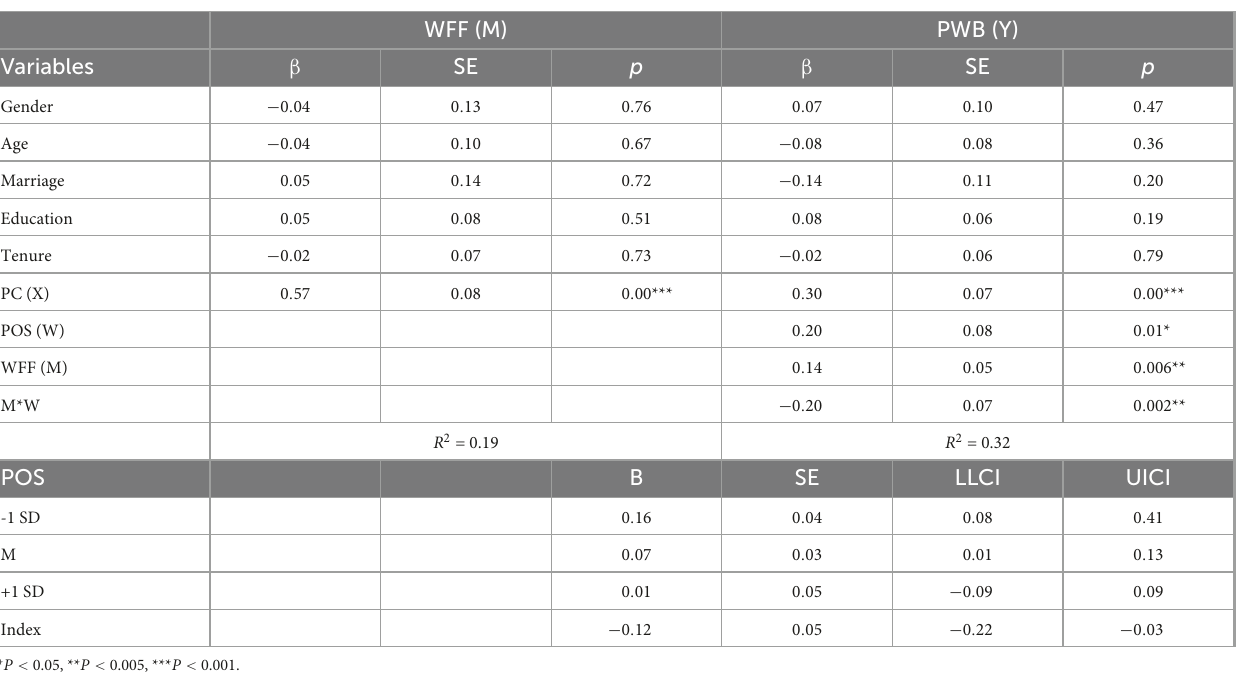
To better understand the moderating effect, we followed Aiken and West (1991) to plot the interaction by calculating slopes one SD (standard deviation) above and one SD below the average value of POS. Figure 5 showed the interaction pattern. The findings in Table 8 also revealed that the conditional indirect effect was stronger in the low POS condition ( β = 0.11, CI 0.05, 0.18), and weaker in the high condition ( β = 0.01, CI –0.04, 0.05). In addition, the moderated mediation index denoted the difference between high and low conditional effects (Index = − 0.08, CI –0.15, –0.03) and the CI did not include zero. Thus, these results supported